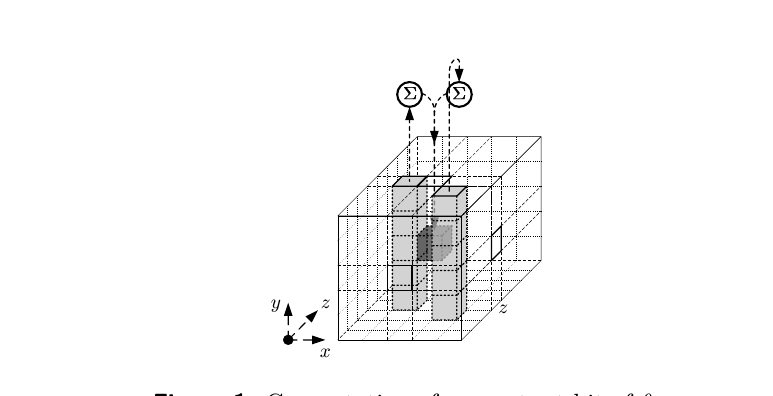
Figure 1: Computation of one output bit of θ